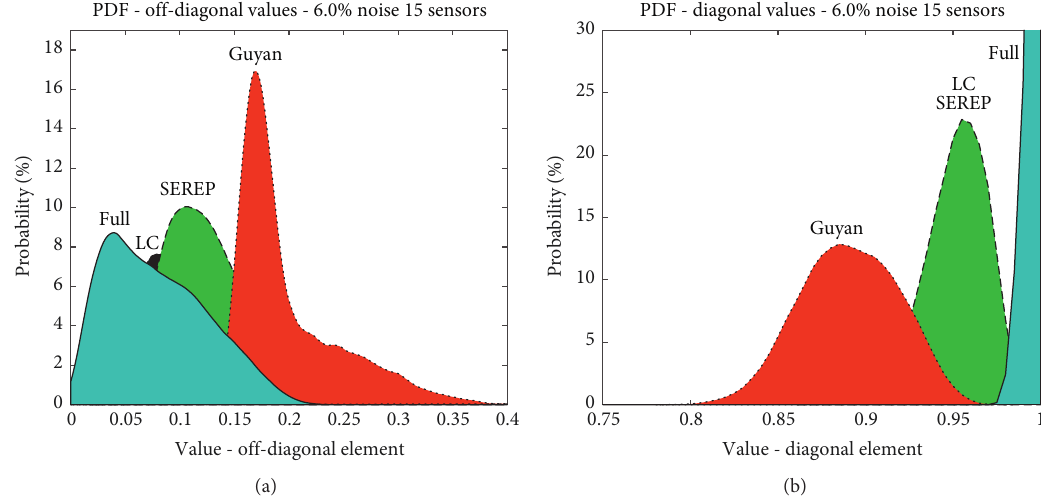
Figure 8: (a) PDFs of the maximal off-diagonal elements. (b) PDFs of the minimal diagonal elements. Both with 6 pct. Noise on the modes and 15 sensors.